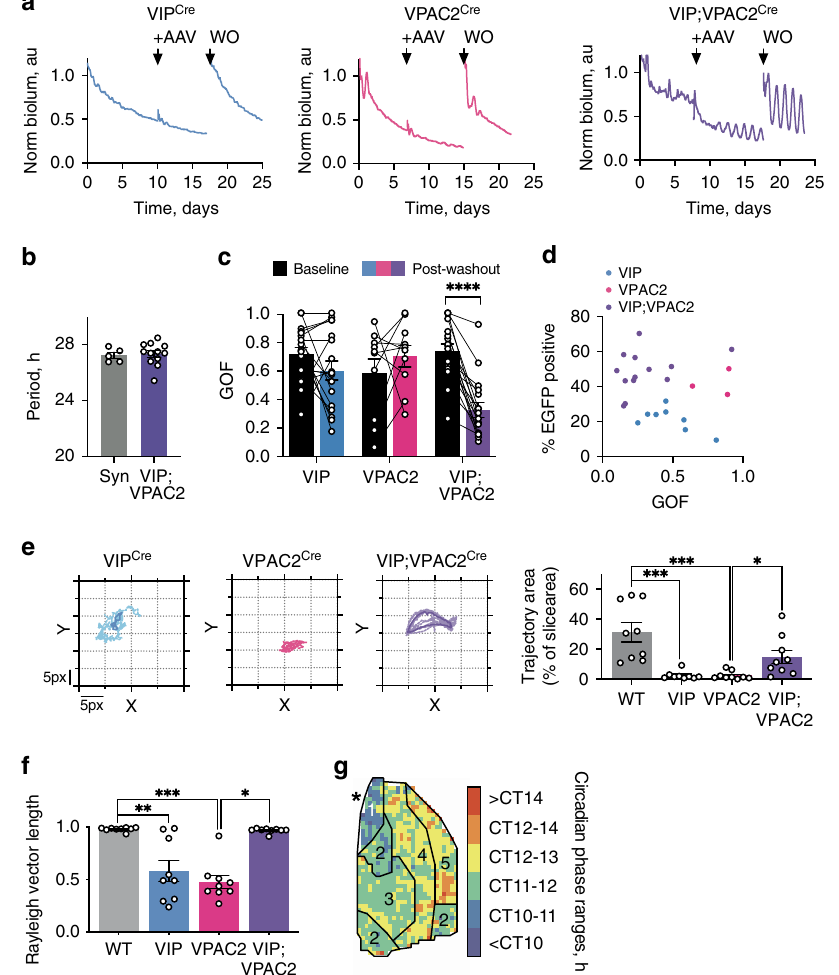
Fig. 7 Conditional Cry1 expression in the VIP-VPAC2 cellular axis of Cry-null SCN is suf fi cient to initiate and sustain circadian rhythmicity. a Representative Per2::Luciferase PMT traces of Cry-null SCN, before and during initiation of conditional Cry1-expression, and after AAV washout (WO) in VIP Cre (blue, left), VPAC2 Cre (pink, middle) and VIP Cre ;VPAC2 Cre slices (purple, right). Arrows indicate AAV addition and washout. b Summary periods for pan-neuronal (Syn, grey, n = 5) or VIP Cre ;VPAC2 Cre (purple, n = 12) Cry1 expression. c Paired goodness of fi t (GOF) measures for baseline (black) and post-washout (coloured) for VIP Cre (blue, n = 18), VPAC2 Cre (pink, n = 10) and VIP Cre ;VPAC2 Cre (purple, n = 17) SCN ( p < 0.0001). d Percentage of Cry1:: EGFP positive SCN cells versus the GOF for VIP Cre (blue, n = 8), VPAC2 Cre (pink, n = 3) and VIP Cre ;VPAC2 Cre (purple, n = 13) conditional Cry1-expressing SCN. e Representative CoL trajectories showing relative spatial organisation of VIP Cre (blue, n = 9), VPAC2 Cre (pink, n = 9) and VIP Cre ;VPAC2 Cre (purple, n = 9) in Cry-null SCN conditionally expressing Cry1 (left) alongside summary trajectories (right) including wild type (grey, n = 9) (* p = 0.047, *** p < 0.001). Lighter lines indicate individual cycles, darker lines indicate the mean of the individual cycles. f Summary Rayleigh vector length for wild-type SCN (grey, n = 9), or VIP Cre (blue, n = 9), VPAC2 Cre (pink, n = 9) and VIP Cre ;VPAC2 Cre (purple, n = 9) Cry-null SCN conditionally expressing Cry1 (* p = 0.027, **0.004, *** p = 0.0002). g Representative categorical, annotated phase map showing spatial phase distribution in VIP Cre ;VPAC2 Cre Cry1-initiated SCN, asterisk indicates third ventricle. In all plots: Individual points (paired/unpaired) represent individual slices; bars represent mean ± SEM. Statistics: b unpaired two-tailed t- test, c repeated-measures two-way ANOVA; e , f Ordinary one-way ANOVA. Only signi fi cant comparisons ( p < 0.05) are shown. Source data are provided as a source data fi